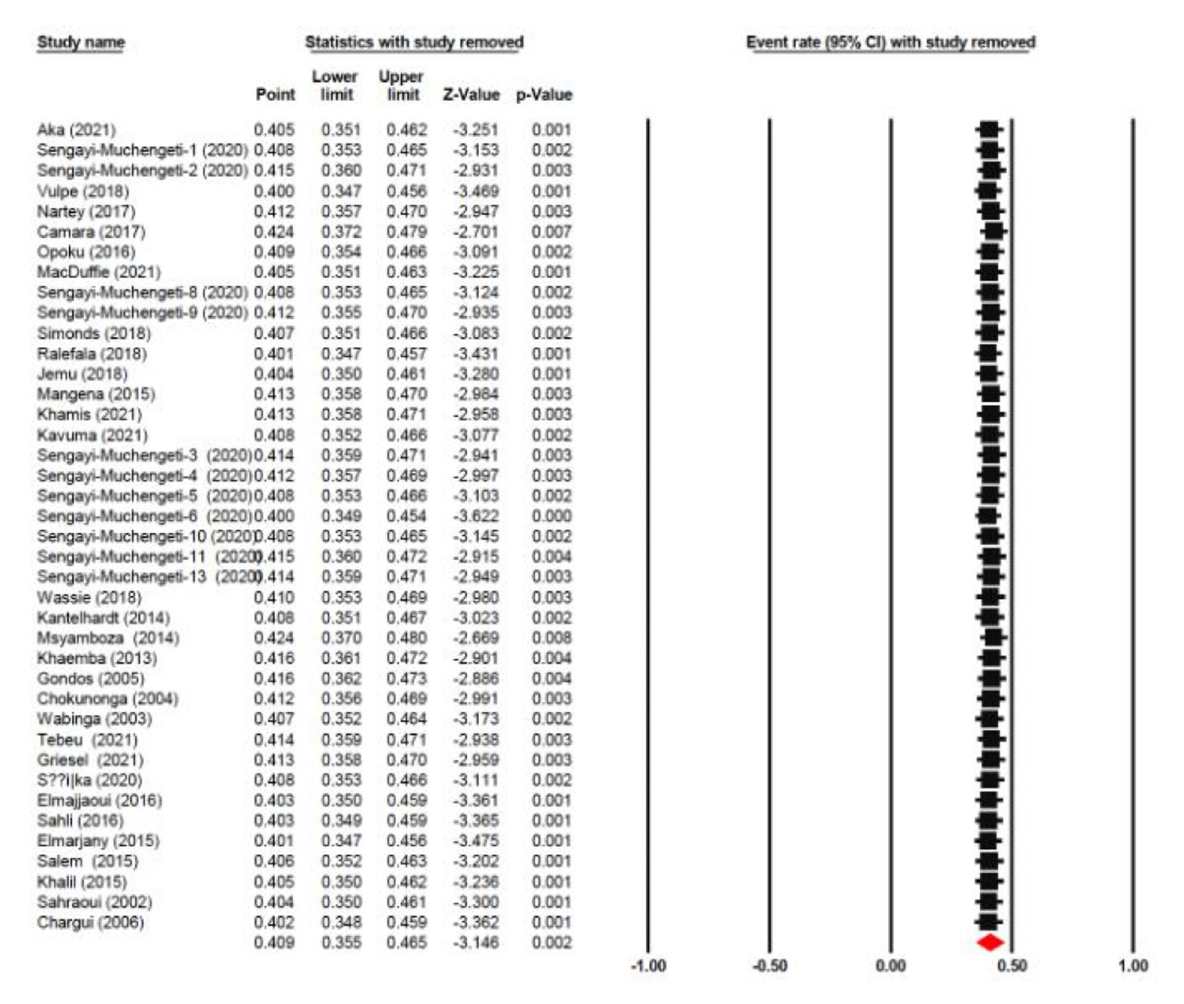
FIGURE9 Sensitivity analysis plot of pooled